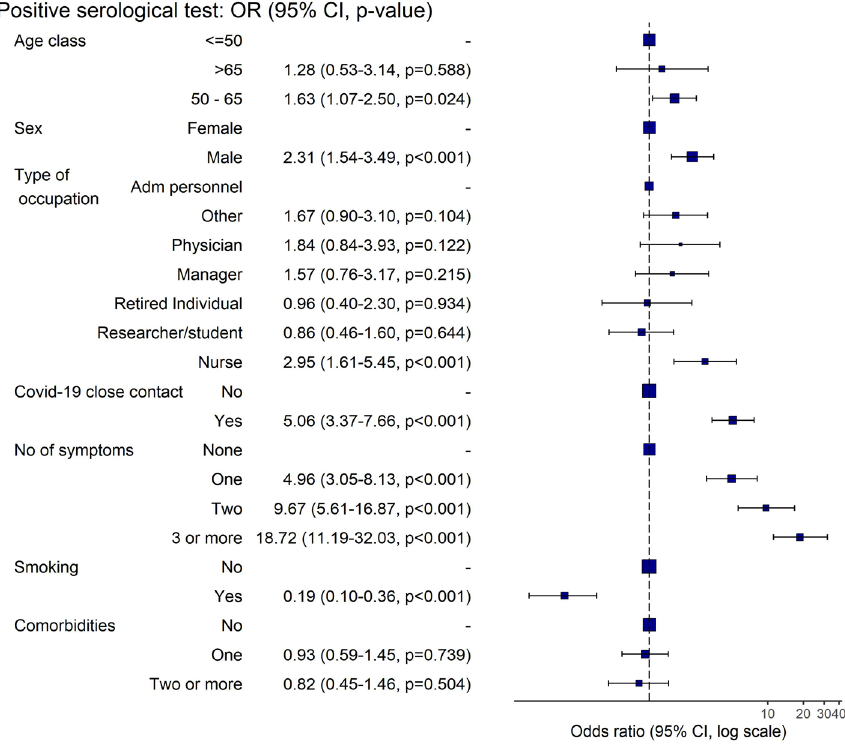
Figure 2. Multivariable logistic regression on qualitative in vitro detection of antibodies levels dichotomized as positive/negative as response at baseline, considering demographic features, exposure to COVID-19 contacts, number of comorbidities, and symptoms. Blue squares and horizontal lines represent ORs and their 95% CI; the dashed vertical line is at OR = 1 (no association). Squares to the left of the dashed line represent protective association, whereas squares to the right are indicative of positive association with Anti-SARS-CoV-2 S test positivity (risk factors). Confidence intervals crossing the dashed vertical line indicate no significant association.